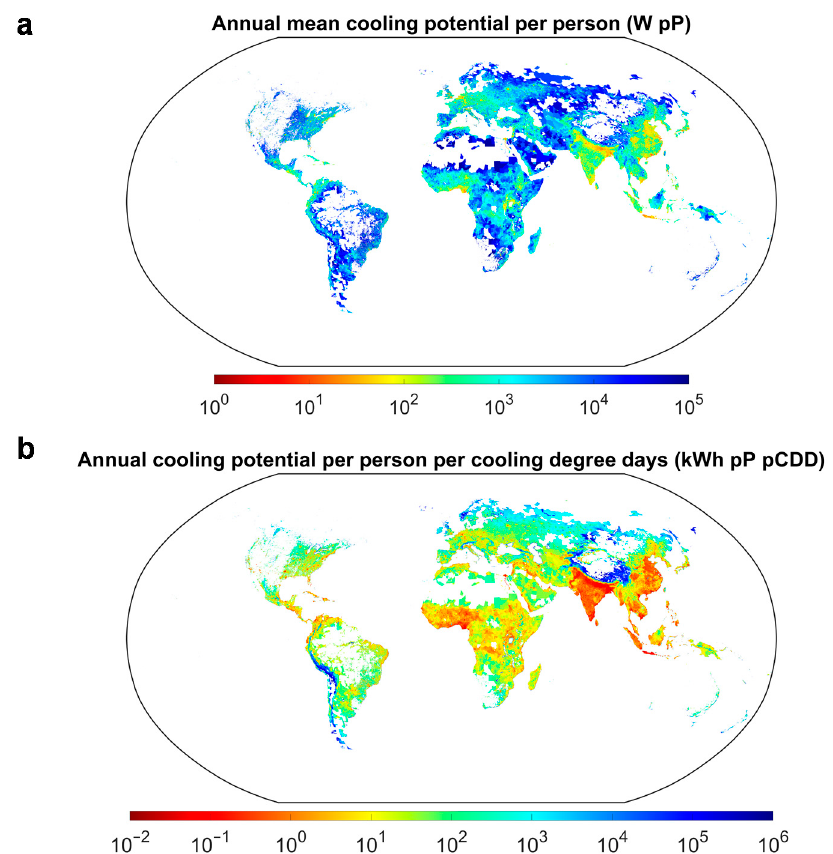
Figure 9. The adjusted annual cooling potential maps when 0.1% land area is used for radiative cooling applications. Unpopulated regions (less than 1 person per km 2 ) are not considered. ( a ) Annual mean cooling potential adjusted for the global population density (Watts per person, W pP). ( b ) The annual total cooling potential adjusted for the global population density and annual cooling degree days (Watts per person per cooling degrees, W pP pCDD).